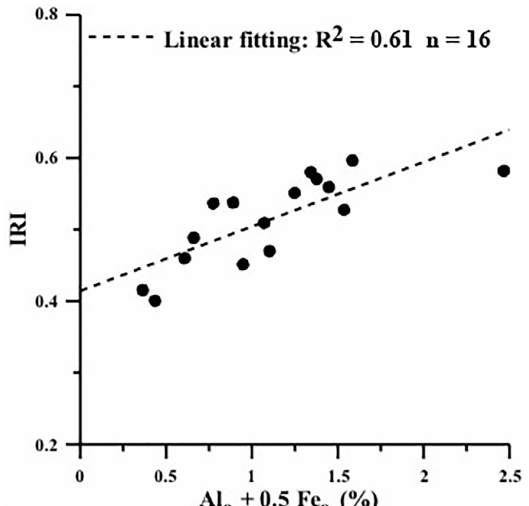
Figure 3. Scatterplot between Al o + 0 . 5Fe o index and integrated retention index (IRI) determined in reference A and B horizons. Coefficient of determination R 2 along with points ( n ) is